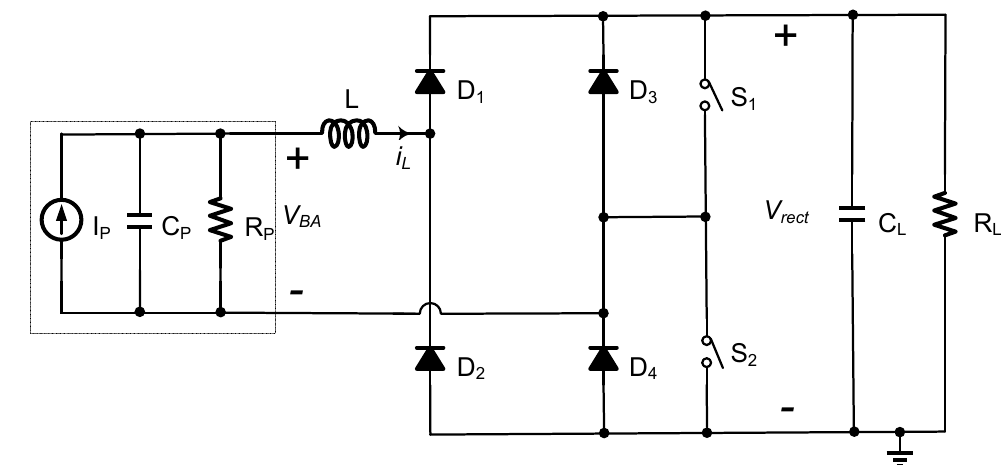
Figure 4. Proposed hybrid Synchronized Switch Harvesting on Inductor (SSHI) circuit integrated with a diode bridge rectifier.